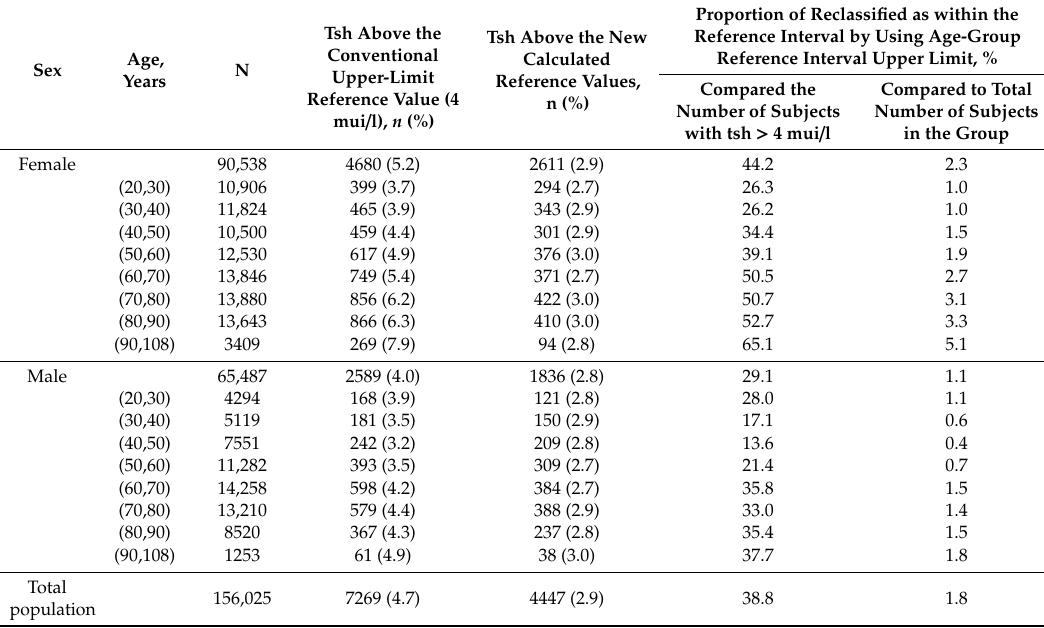
Figure 4. Modeled thyrotropin (TSH) distribution by age group and sex. ( A ) Modeled TSH distribution according to age group in both sexes. ( B ) Modeled TSH distribution according to age group and sex. Values for females are presented as a continuous line and for males as a dotted line. Table 2. Reclassification of samples according to sex and age